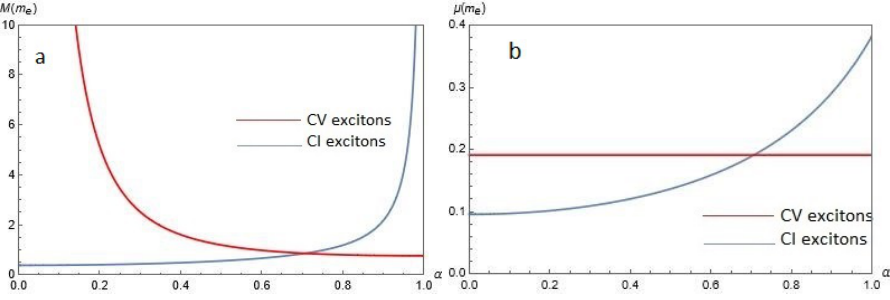
Figure 6. The effective masses of dipolar excitons for CV and CI excitons as functions of the hopping parameter α for chosen gap ∆ = 0.5 ¯ hv F / a for ( a ) center-of-mass exciton mass M in the left panel and ( b ) reduced exciton mass µ , on the right.